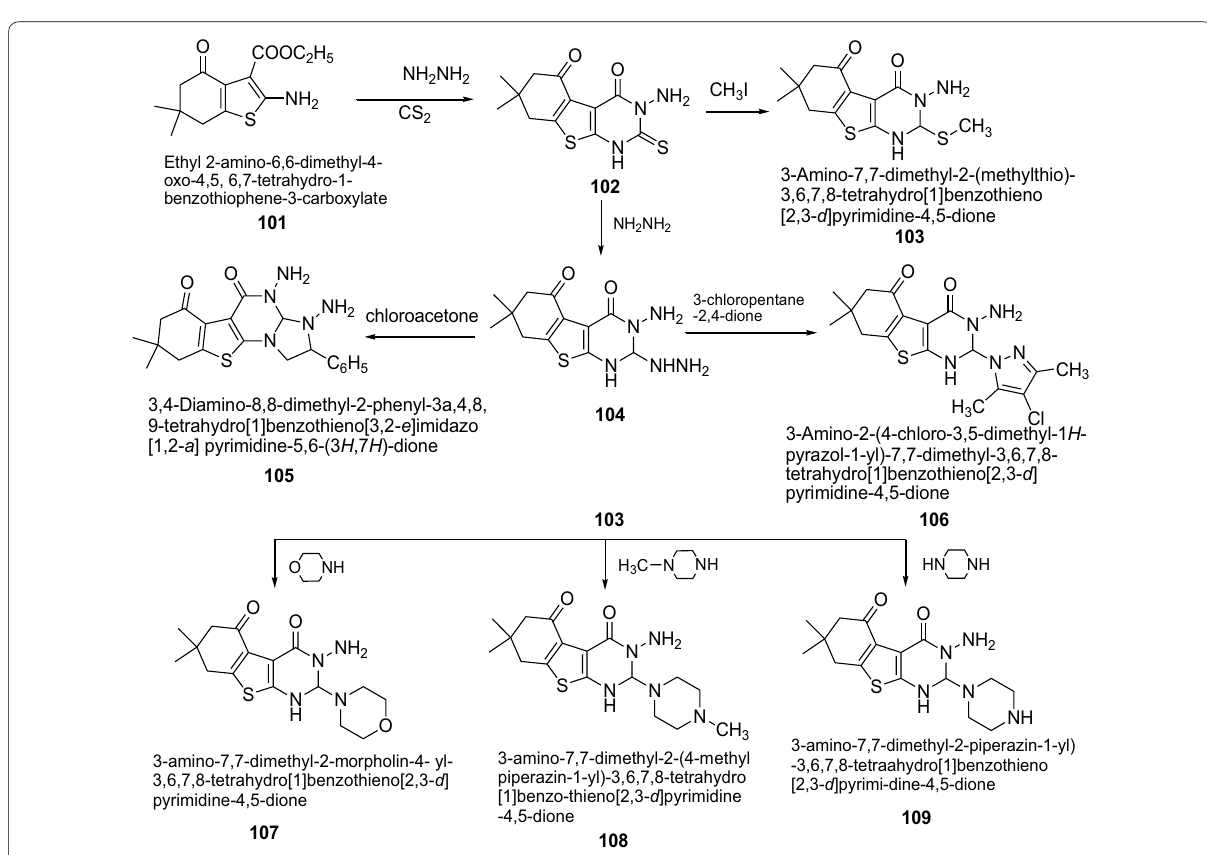
Table 22 Anti-inflammatory activity of some synthesized compounds were evaluated by applying carrageenan- compounds (% reduction in edema induced by yeast) induced paw edema bioassay in rats using indometha- cin as a reference standard. Compounds 105 , 106 , 107 , Compound Post treatment 3 h = 108 and 109 caused significant decreases in paw edema after 2, 3, 4 h after drug administration. Thus, it can be concluded that spirobenzothienopyrimidine moiety, phenylpyrazolothinopyrimidine, morphonyl and piper- azinylthinopyrimidine ring systems are important for